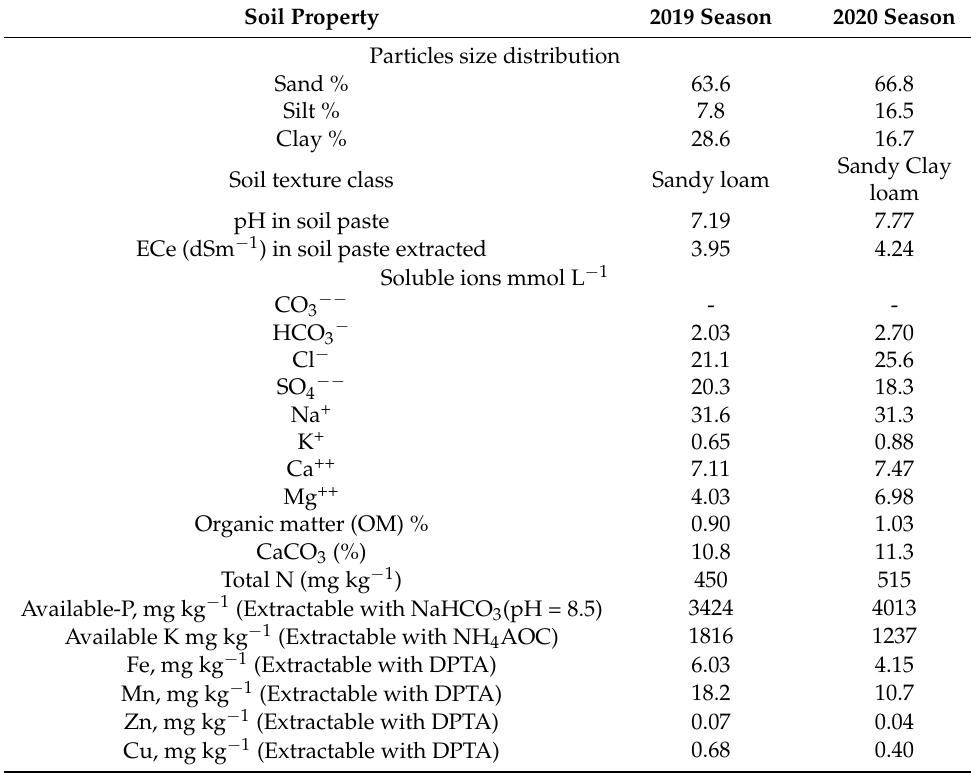
Table 2. Some physical and chemical soil characters of the experimental sites before transplanting in seasons 2019 and